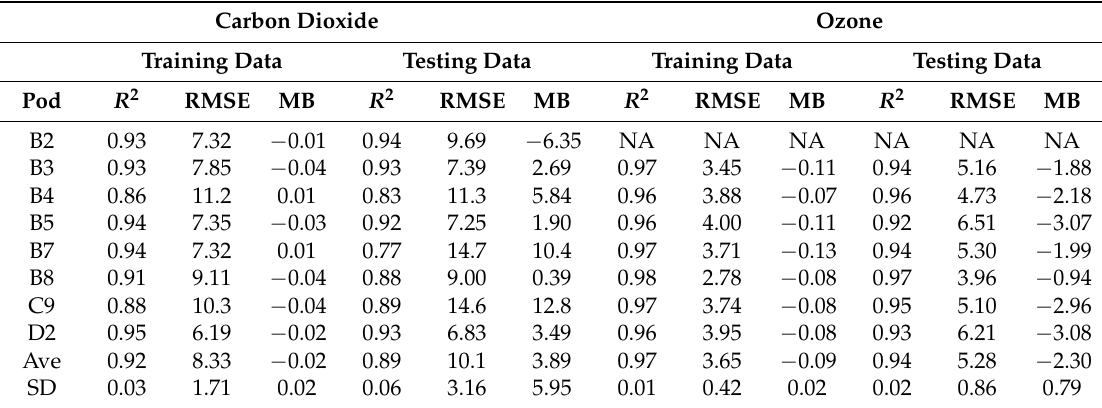
Table A1. Performance Statistics for each Y-Pod; RMSE—CO 2 (ppm) & O 3 (ppb); MB—Mean